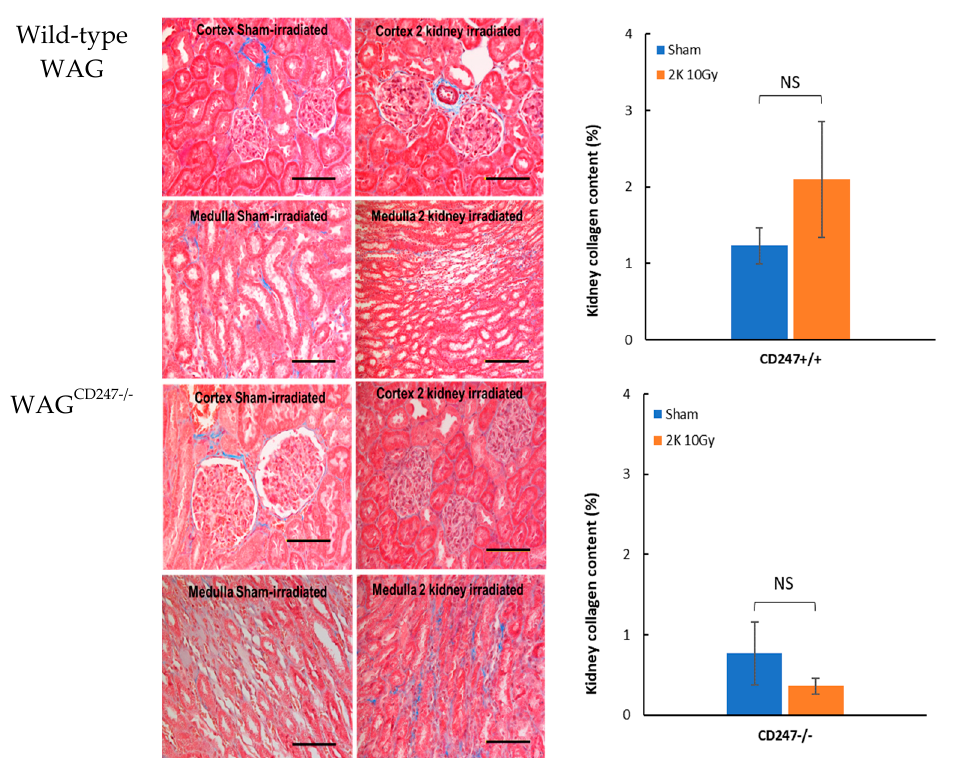
Figure 8. Collagen deposition in kidney after local irradiation with 10 Gy of X-rays in wild type WAG and WAG CD247-/- rats. Trichrome staining of kidney. The horizontal scale bar represents 100 microns. Images are representative data from 3–4 animals per group. Quantification of collagen deposition in kidney. Data are mean + SEM.